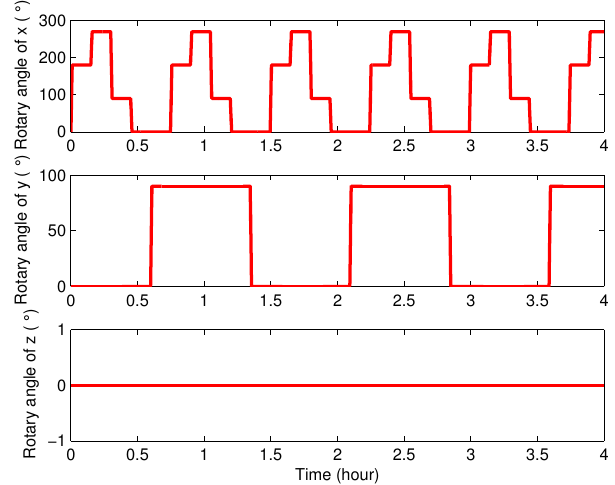
Figure 3. The rotary angle model of the proposed rotary scheme, which was rotating about the x axis and y